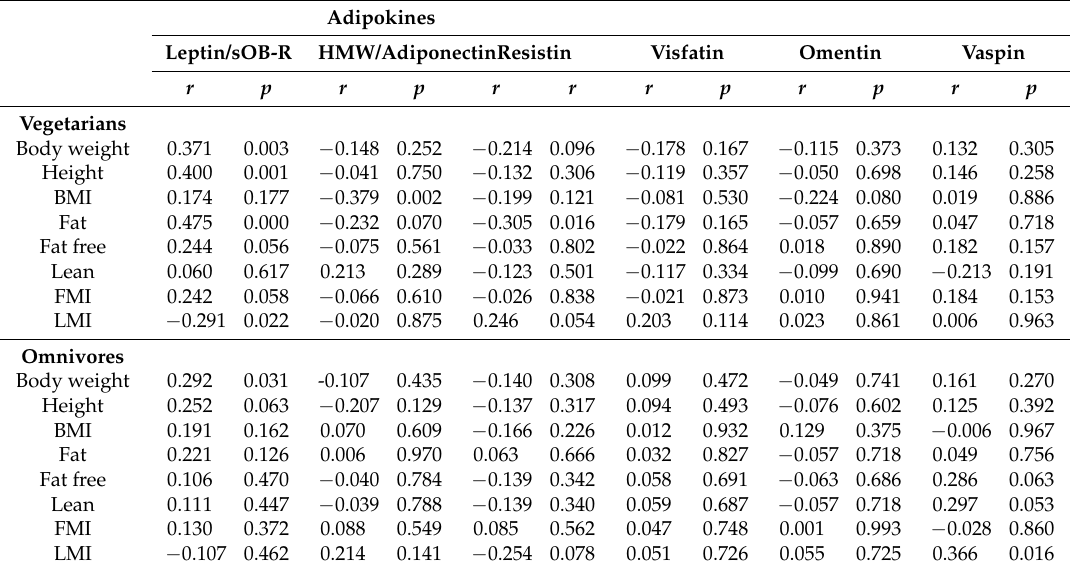
Table 3. Correlation analysis between serum adipokine concentrations and anthropometric variables in children on vegetarian and omnivorous diets.